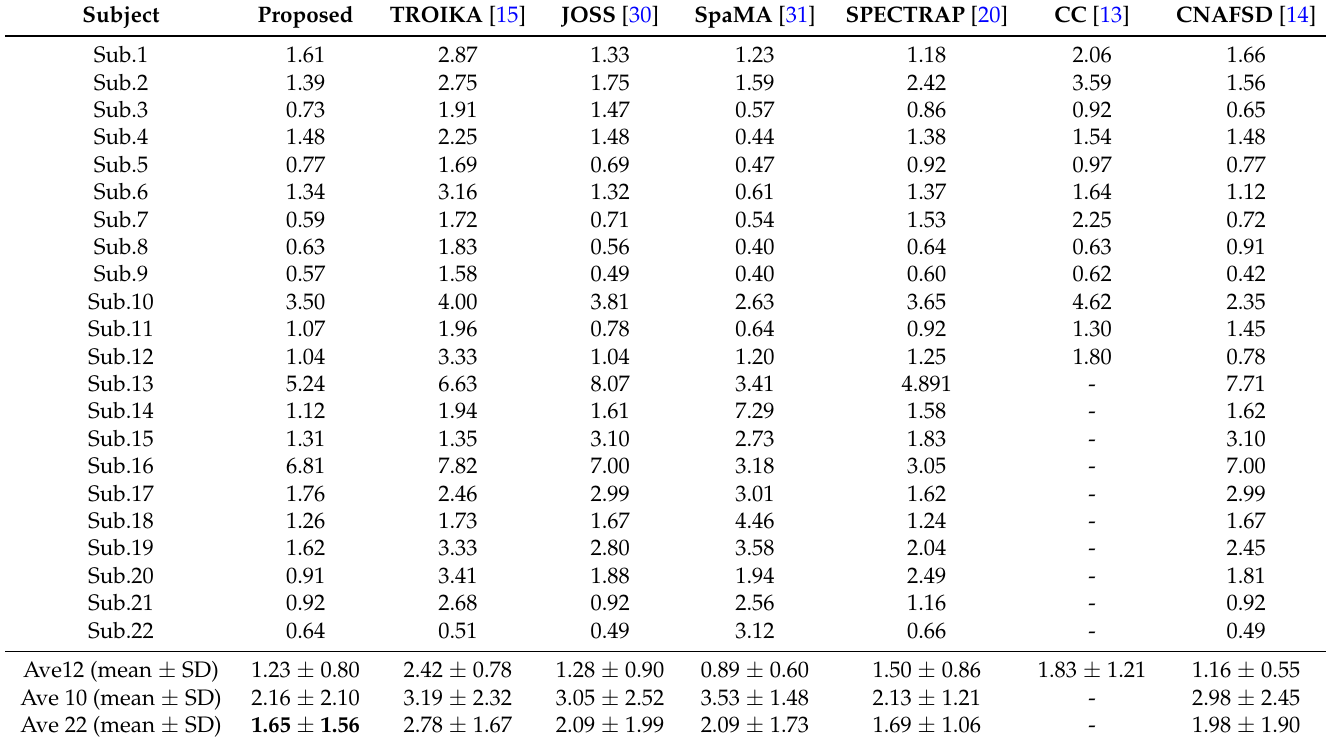
Table 1. The HR estimation results in terms of AAE on the 22 PPG datasets. Average absolute error